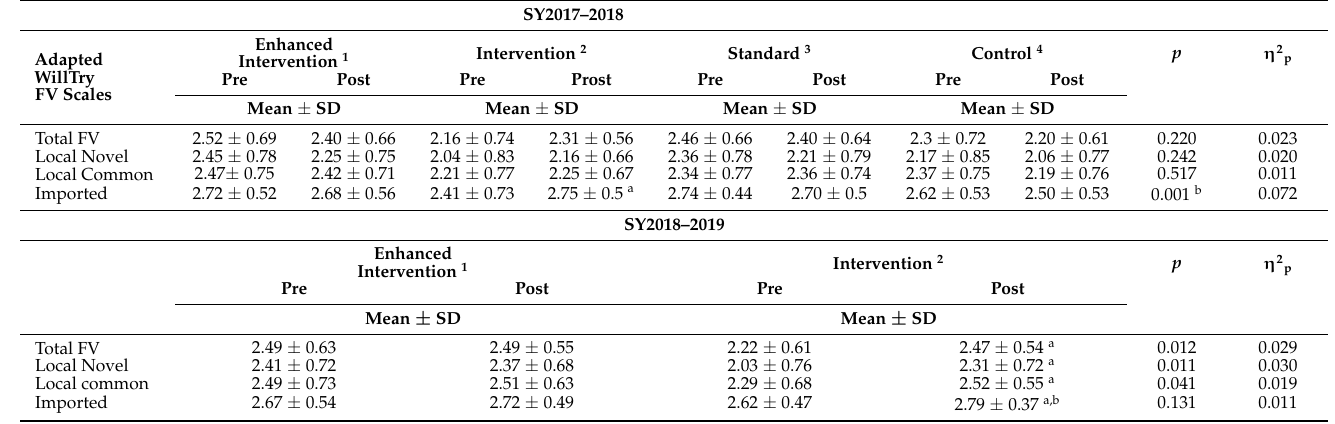
Table 2. Means, standard deviations (SD), and mixed ANOVAs interaction effects between time and group for all Adapted WillTry fruit and vegetable (FV) pre- and post-scores by study group in both school years a